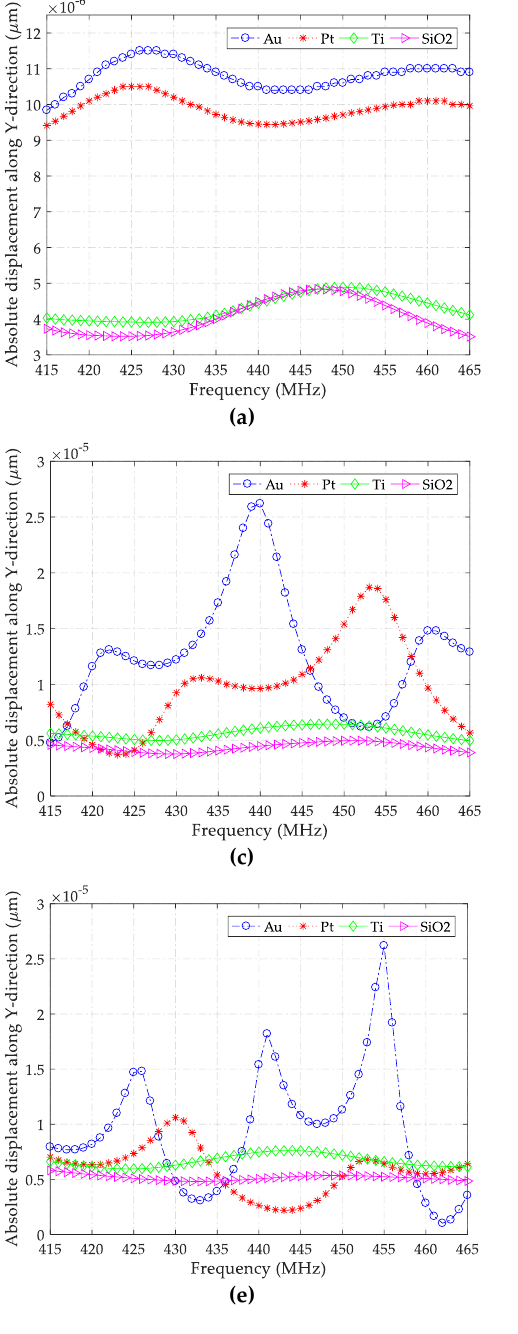
Figure 6. Absolute displacements of SH-SAWs in the Y-direction for various h layer / λ ratios: ( a ) 0.01; ( b ) 0.015; ( c ) 0.02; ( d ) 0.025; ( e ) 0.03; and ( f ) 0.035.